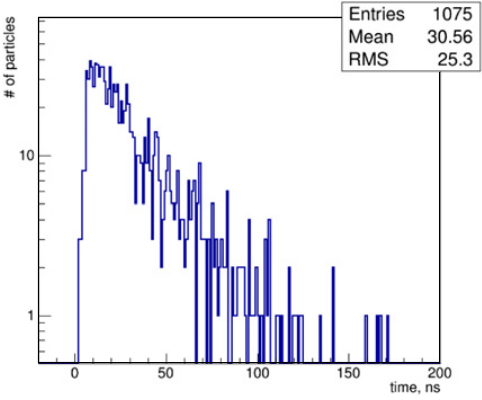
Figure 4. Charged particles arrival time at 100 m from EAS